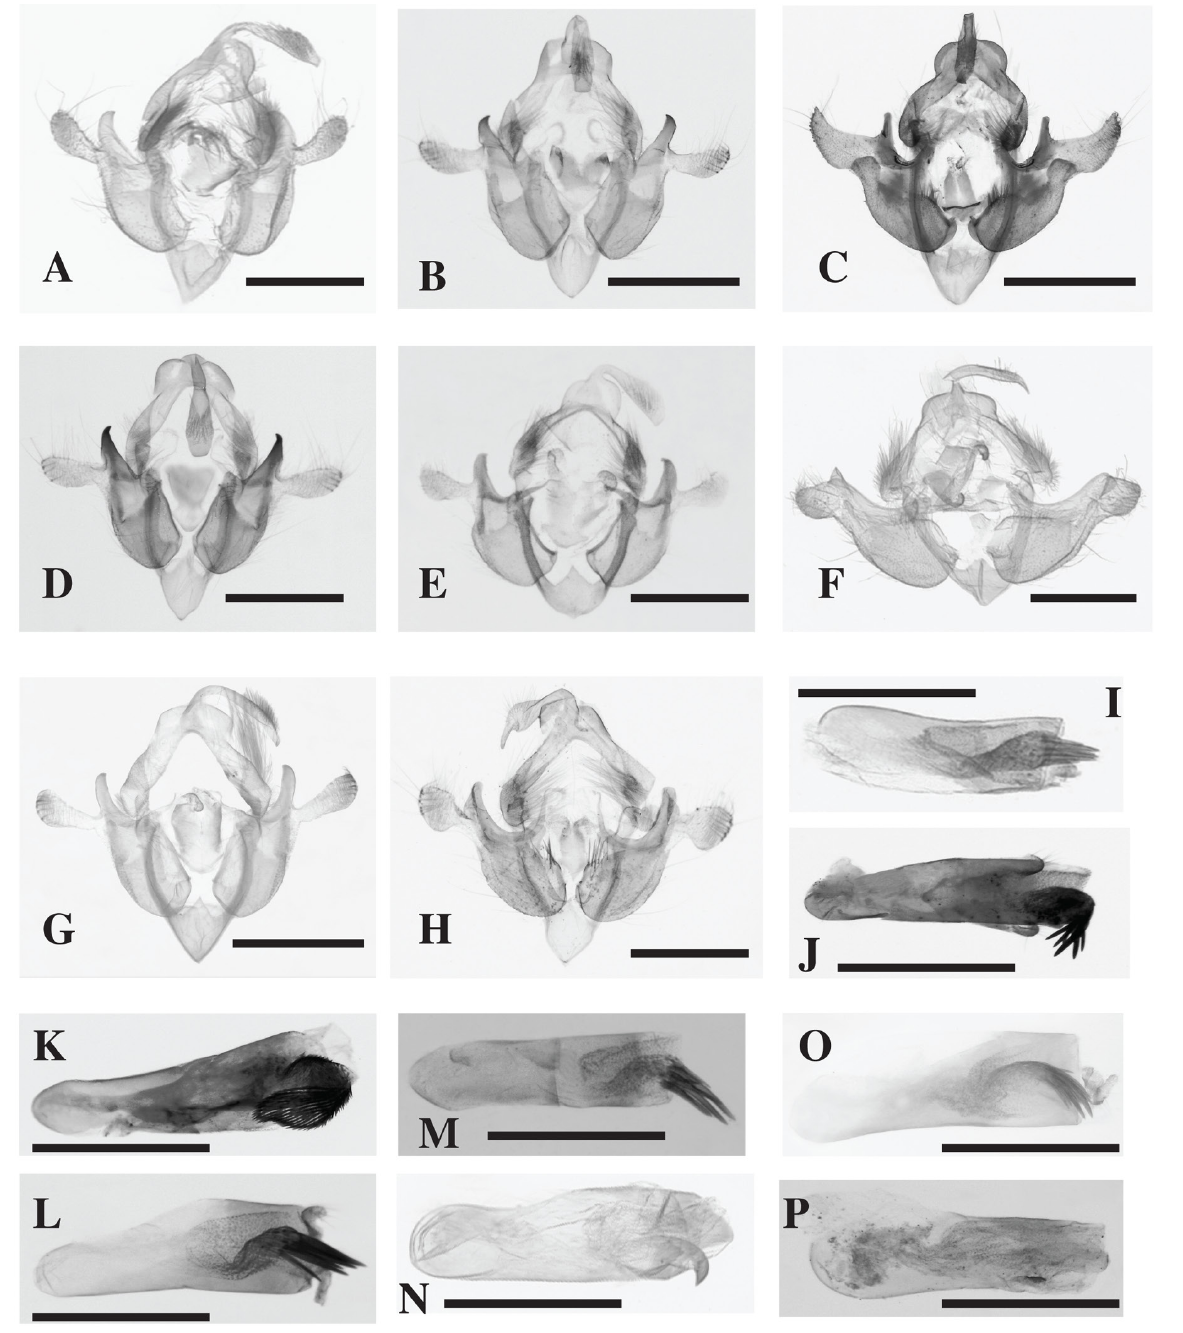
Fig. 2. Male genitalia of species of Acrapex . – A , I . A. cuprescens (Hampson, 1910). – B , J . A.